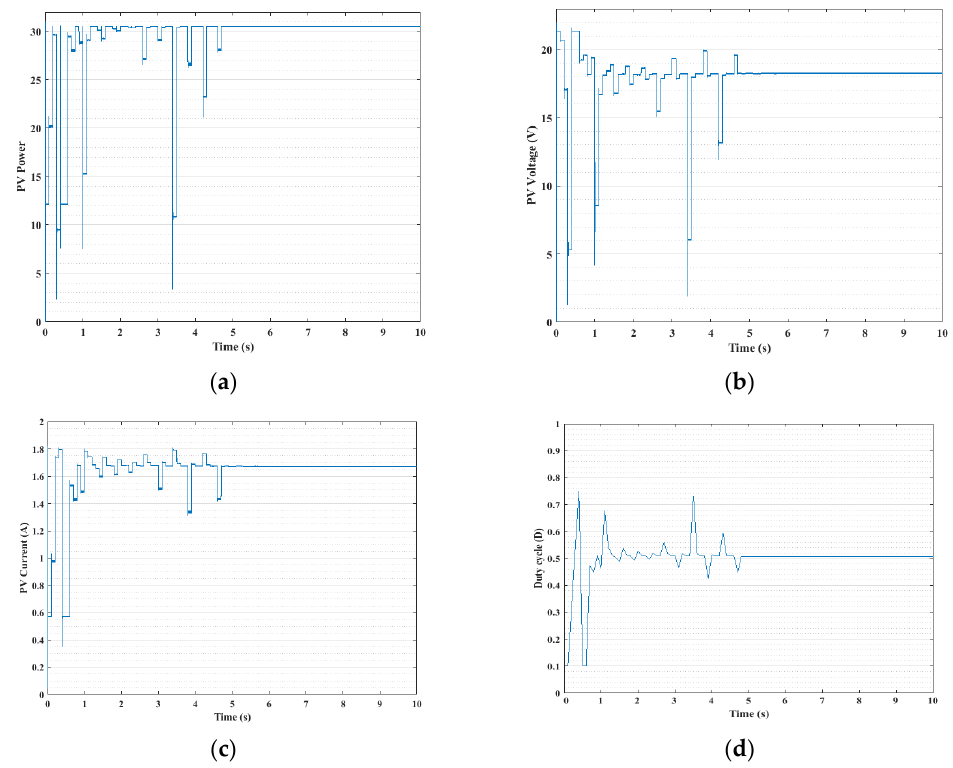
Figure 11. Modified LFO at 600 W/m 2 irradiance. ( a ) power ( b ) voltage ( c ) current ( d ) duty